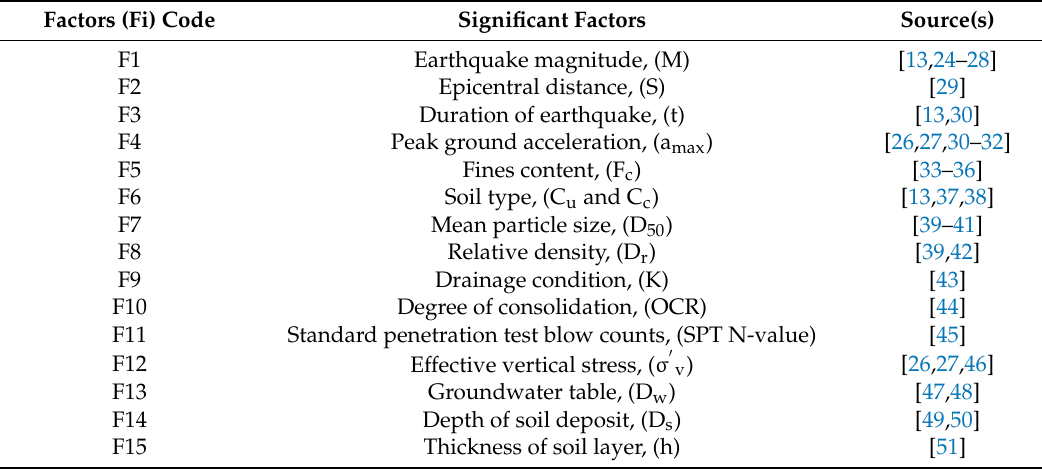
Table 1. List of significant factors identified from literature